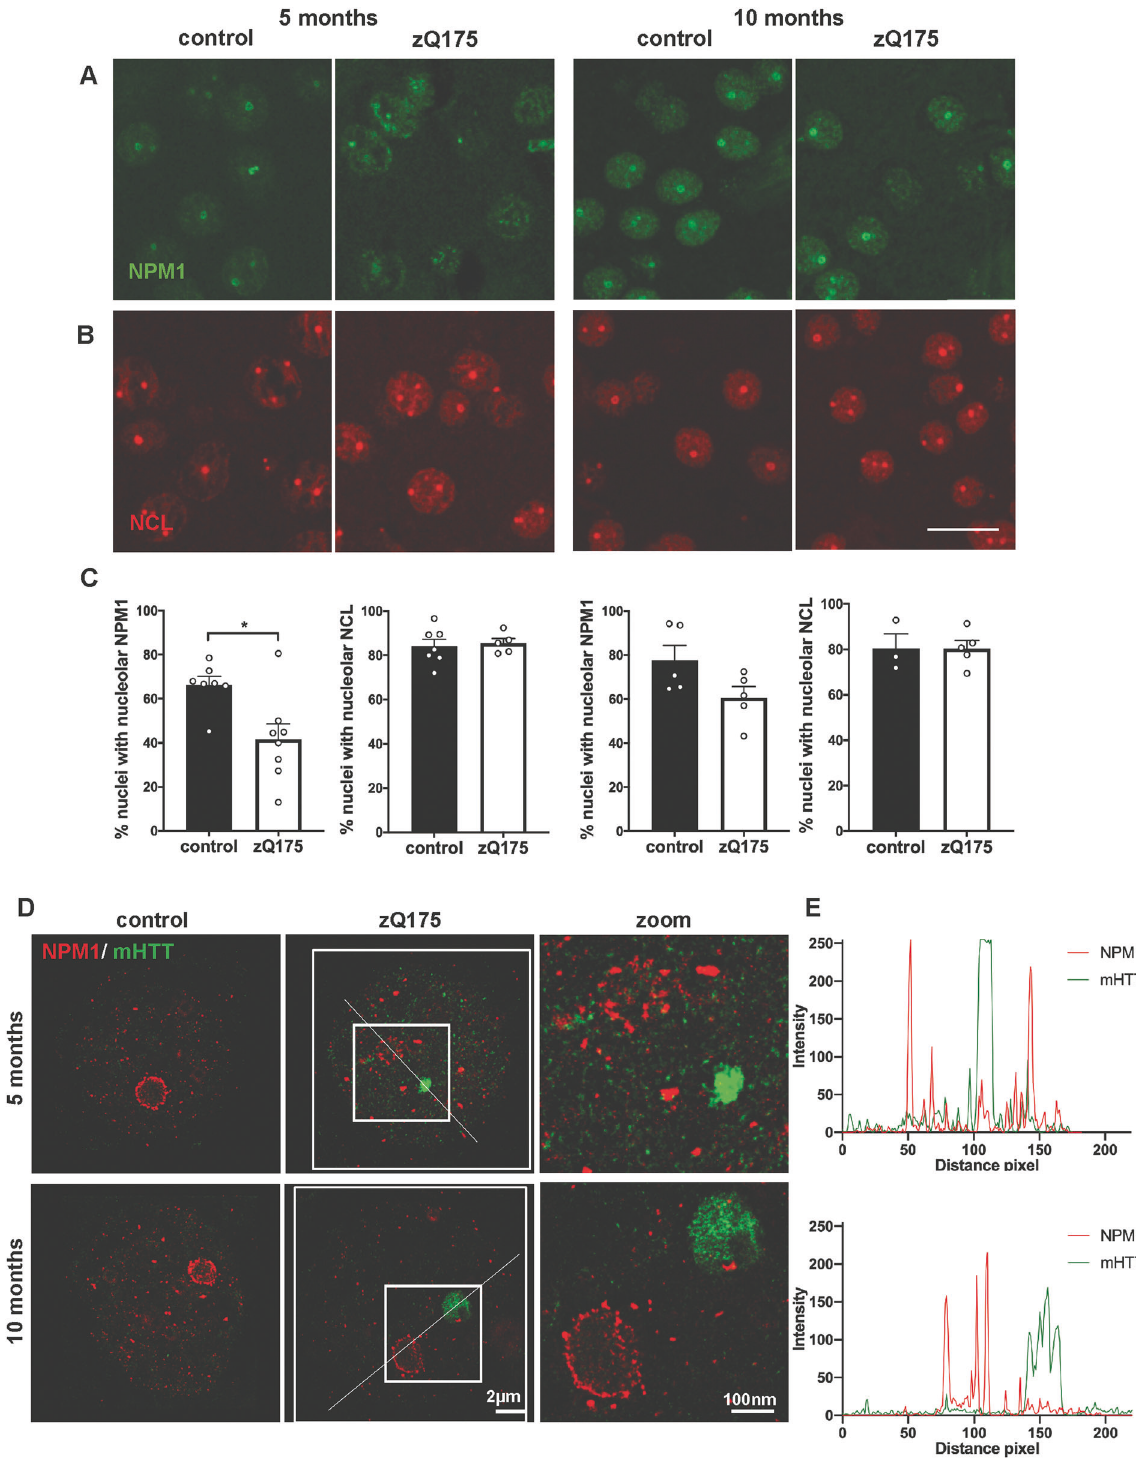
Fig. 4 Redistribution of NPM1 in the striatum of pre-symptomatic zQ175 mice. A , B Representative confocal images of striatal sections stained for NPM1 (green) and NCL (red) in control and zQ175 mice at 5 and 10 months. Scale bar: 20 µm. C Quanti fi cation of the percentage of nuclei with nucleolar localization of NCL or NPM1 expressed as percentage of nuclei showing them as a circular nucleolar signal at 5 and 10 months in control and zQ175 mice (N: number of mice, control: 7,7,5,3 and zQ175: 8,5,5,5). Signi fi cant decrease in the number of nuclei showing nucleolar NPM1 in the zQ175 mice at 5 months in comparison with their respective controls by Mann – Whitney U test ( p = 0.02). Values represent mean ± SEM. * p < 0.05. D Super-resolution (STED) microscopic images showing loss of NPM1 (red) ring-like organization and its association with disperse mHTT (green) signals at 5 months, but not at 10 months. E Line scans through the boxed regions containing the nucleolus and mHTT inclusion describe the distribution of NPM1 and mHTT signals in the zQ175 mice at both ages. A close proximity of mHTT and NPM1 signals at 5 months can be observed. Scale bar: 2 μ m, zoom: 100